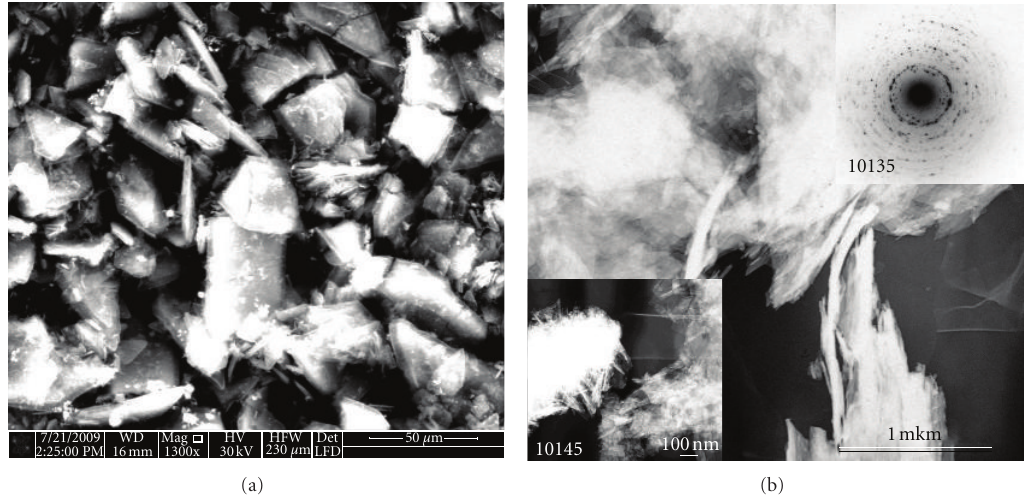
Figure 2: Needle-like crystallite of HA sample before milling (a) SEM and (b) TEM, respectively.